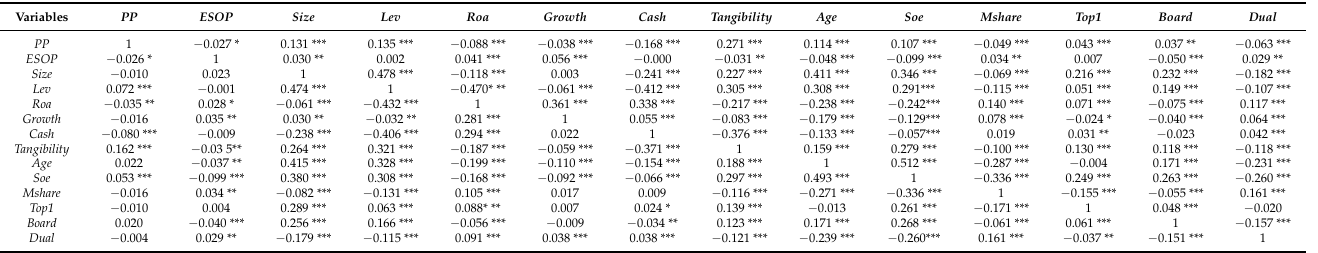
Table 3. Correlation